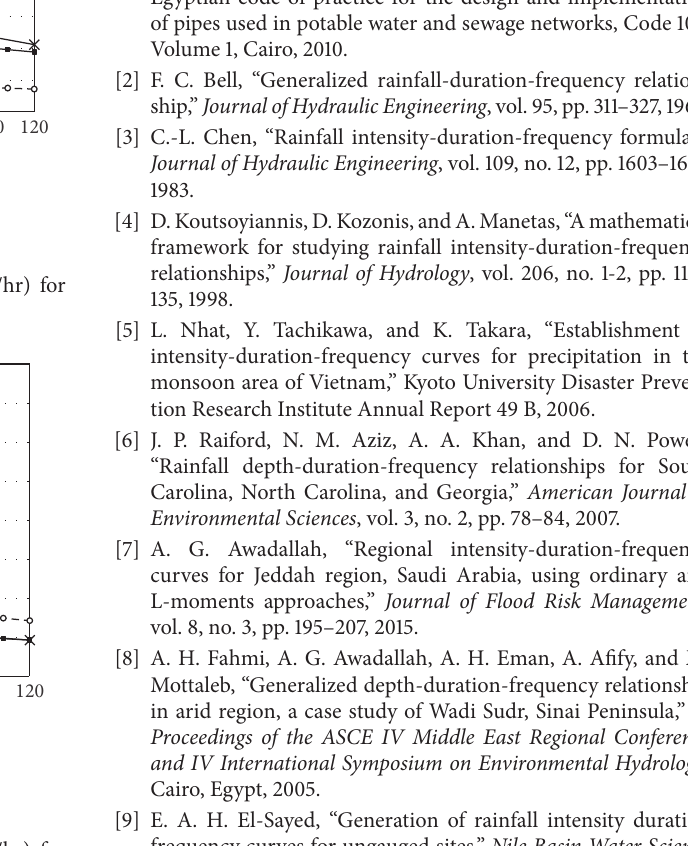
Figure 7: Comparison of rainfall intensity curve 𝐼 (mm/hr) for